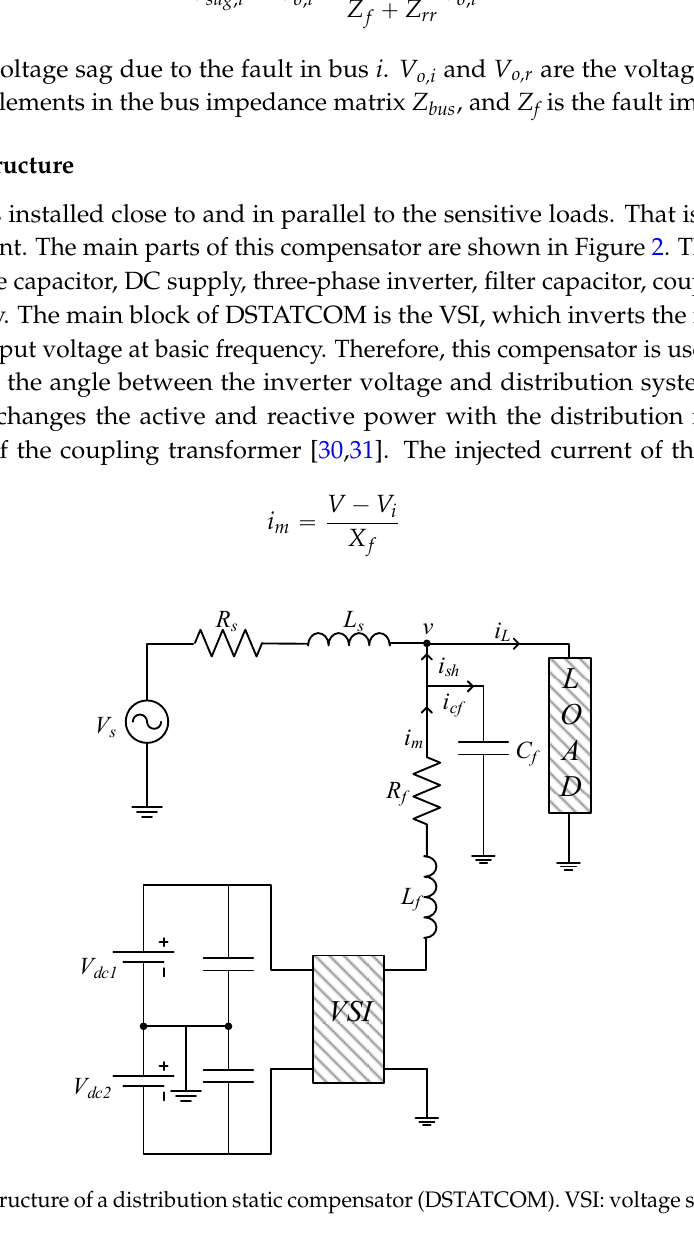
Figure 1. Voltage division model in measuring voltage sag. PCC: point of common coupling.